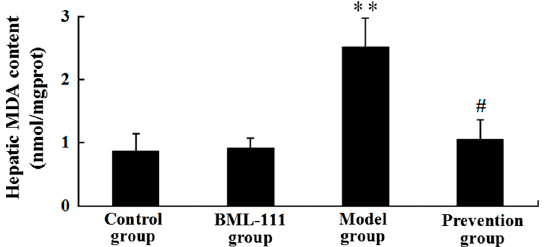
Figure 6. BML-111 reduced the contents of malondialdehyde (MDA). The contents of MDA were evaluated using the assay kit at 8 h after being challenged with LPS/ D -GalN. ** p < 0.01 compared with the control group, and # p < 0.05 compared with the model group ( n = 6).